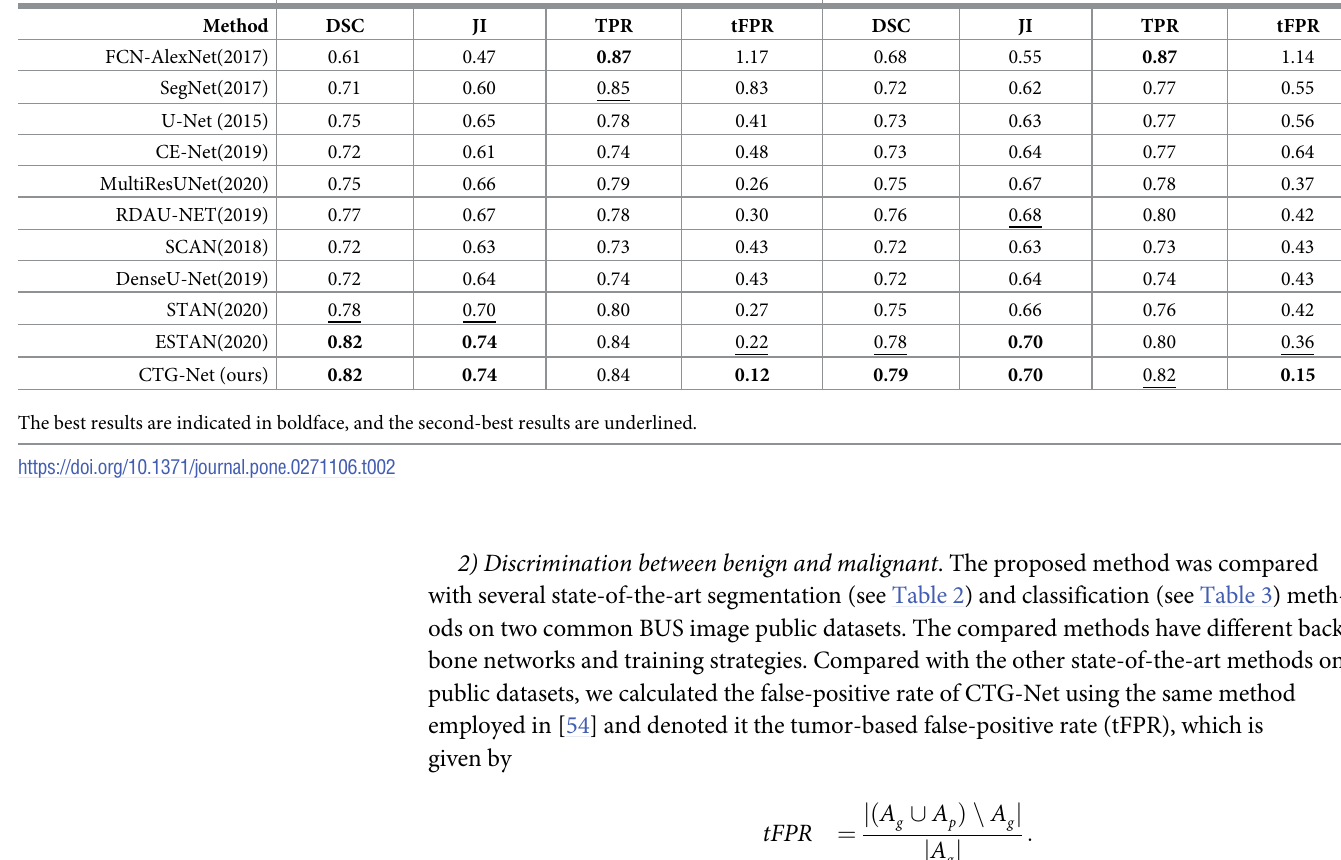
Table 2. Segmentation performance compared with state-of-the-art segmentation models on the UDIAT and BUSI datasets. Dataset UDIAT BUSI Method DSC JI